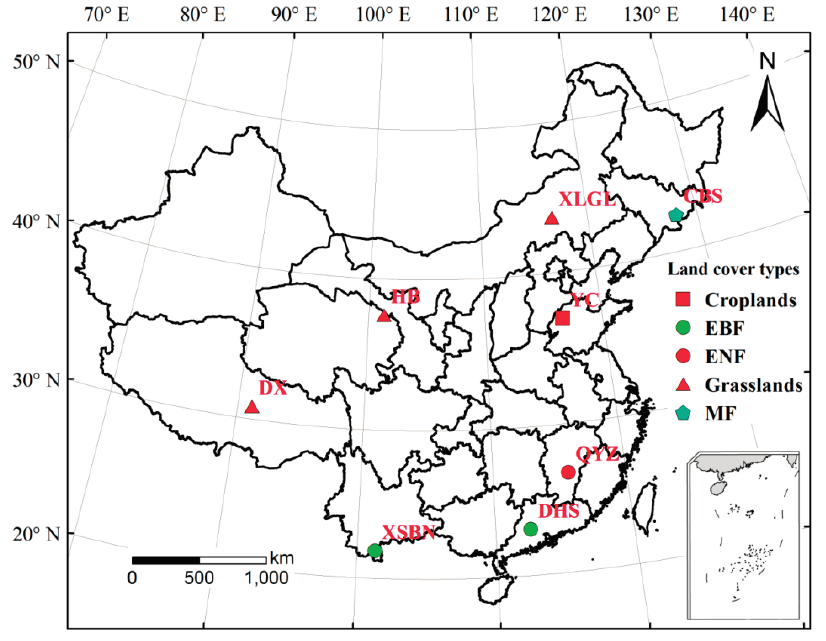
Figure 1. Spatial distributions of eight flux sites in this study. EBF: evergreen broadleaf forests; ENF: evergreen needleleaf forests; MF: mixed